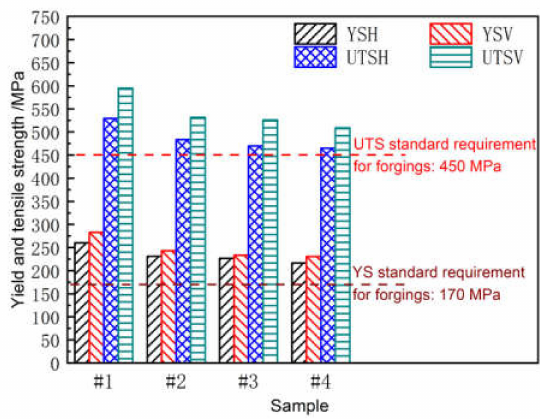
Figure 12. Yield and tensile strength of di ff erent specimens in horizontal and vertical